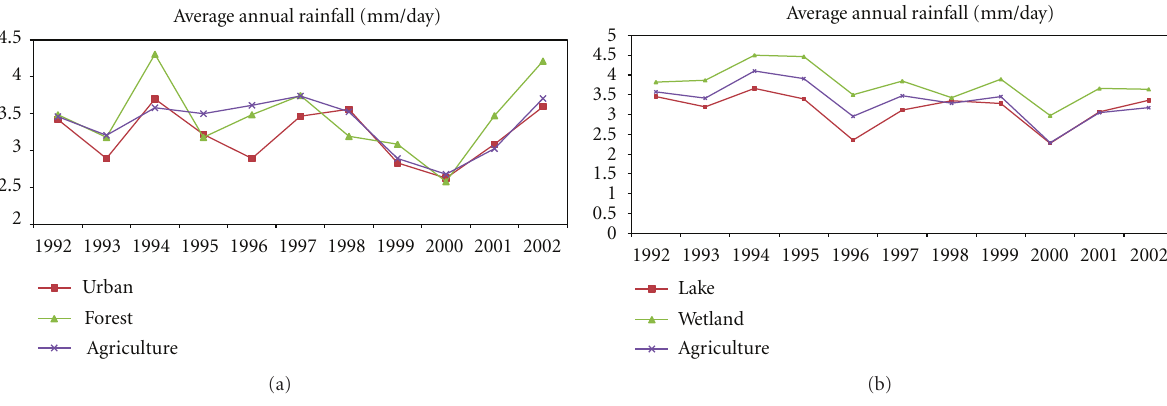
Figure 4: (a) The average annual rainfall in Northeast Florida. (b) The average annual rainfall in South